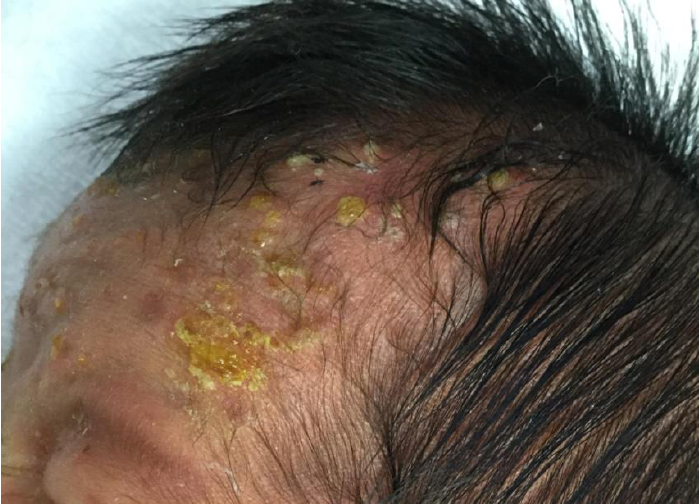
Figure 2. One week after birth, the patient developed ring-shaped plaques consisting of pustules, crusts, and erythema on his scalp and forehead. Pigmentation was seen on the forehead, consistent with previous erythema and pustules.